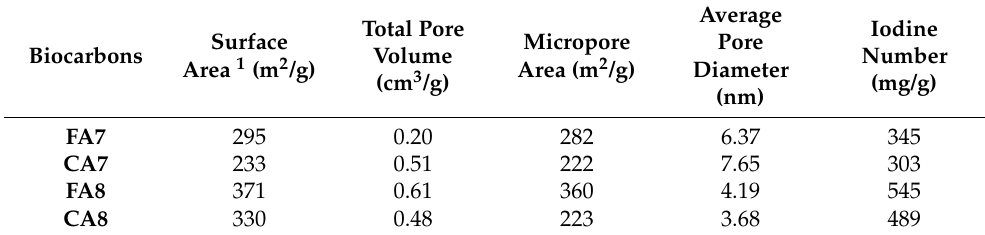
Table 2. Textural parameters and iodine number of the samples obtained.